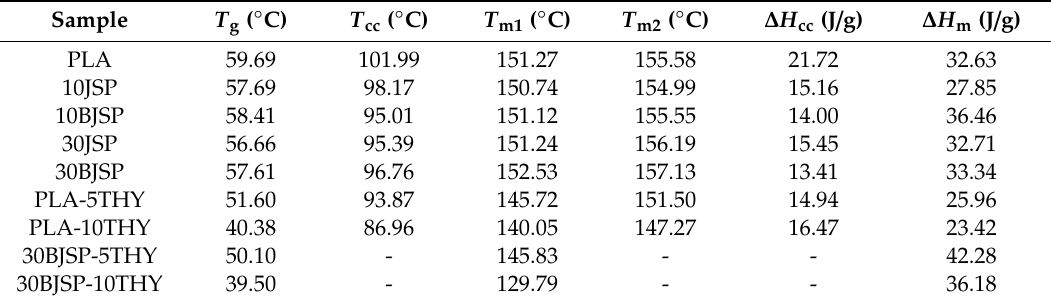
Table2. Thermalanalysisparametersobtainedfromi ff erentialscanningcalorimetry(DSC)thermograms of PLA and its